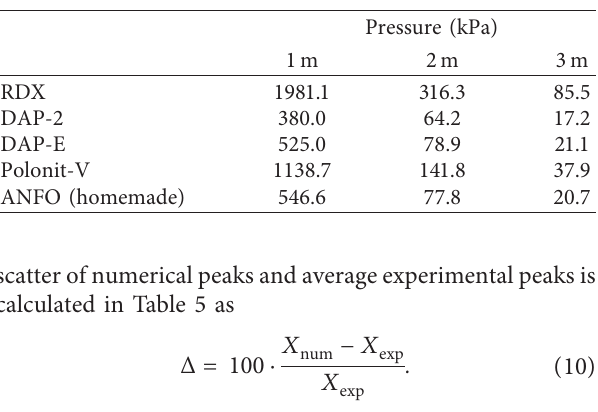
Figure 8: Typical numerical result of the shock wave propagating through the air in one direction (homemade ANFO charge in the example). Distance values are given in mm ( x -axis), while the pressure values are in kPa (example selected at t � 3.16ms after the detonation). Table 4: Numerically derived pressure peaks at 1m, 2m, and 3m from the detonation